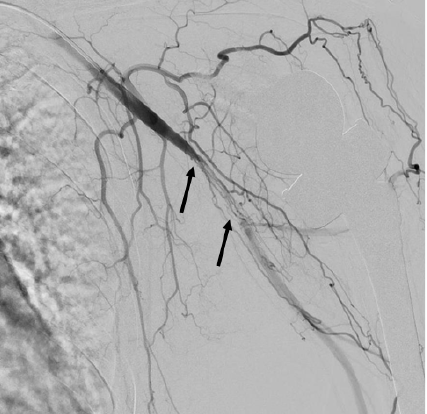
Figure 2: Limited angiography of the left upper extremity showing occlusion of the distal axillary artery and dissection of the proximal brachial artery (arrows).